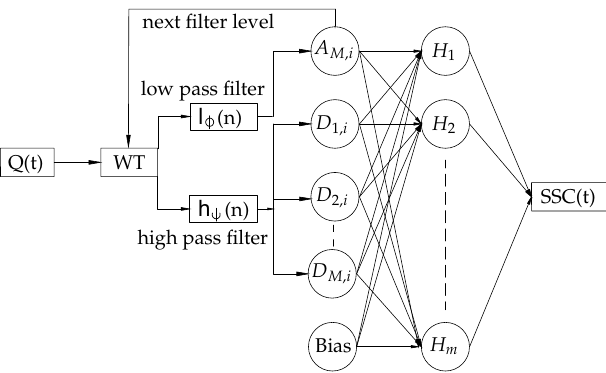
Figure 3. Schematic diagram of a wavelet transform coupled to an artificial neural network (WA-ANN). SSC, suspended sediment